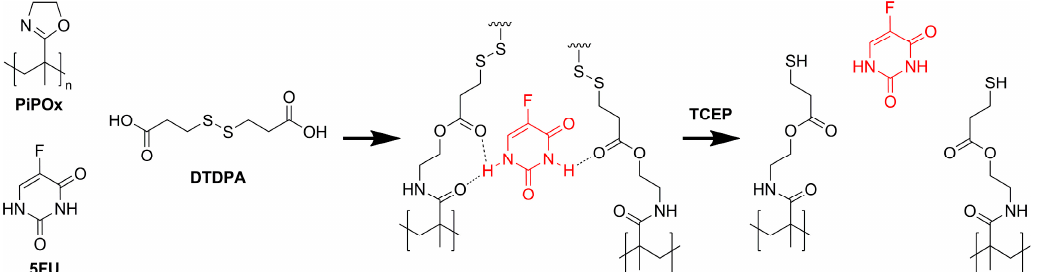
Figure 21. The general overview of the synthesis of poly(2-isopropenyl-2-oxazoline)-based molecularly imprinted polymers (MIPs) using 3,3’-dithiopropionic acid (DTDPA) as a reduction-responsive cross-linker and 5-fluorouracil (5FU) as a template behaviorist subsequent release in the presence of reductive reagent tris(2-carboxyethyl)phosphine) (TCEP). Reprinted from [140]. Copyright (2022), with permission from an open access Creative Commons CC BY 4.0 license.